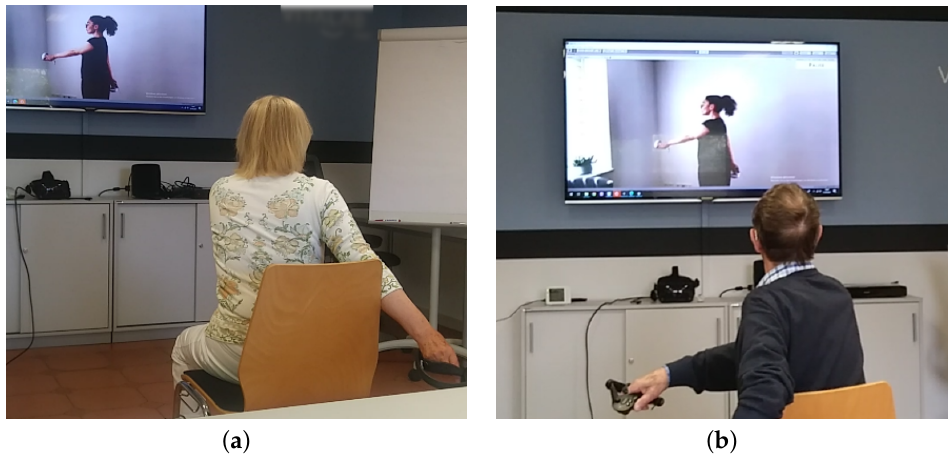
Figure 6. Two participants doing the exercise video. ( a ) A participant doing the exercises in a reversed way compared to the video. ( b ) A participant looking forwards while doing torso